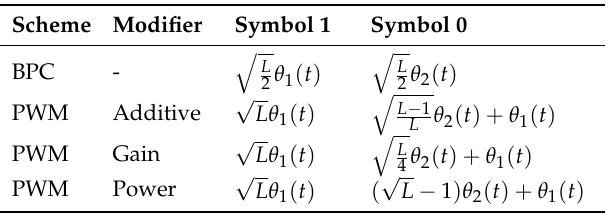
Table 3. Signal space parameters for encoding